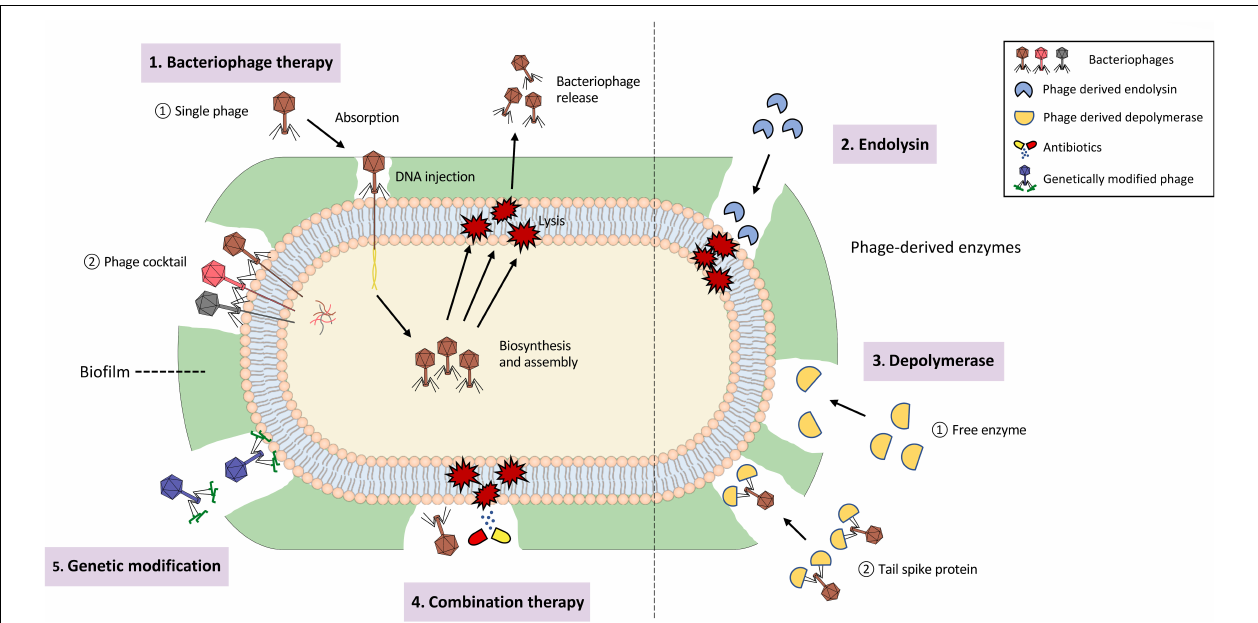
FIGURE 3 | Depiction of biofilm removal using phages and its derived enzymes. (1). Bacteriophage therapy, consisting of single phage therapy and cocktail therapy, that is used for intra- to extracellular degradation of the bacterial structure. (2). Phage-derived endolysin used for extra- to intracellular degradation of the bacterial structure. (3). Phage-derived depolymerase, presented as free enzyme or tail spike protein, that is used for chemical dispersion of the biofilm matrix. (4). Combination therapy using both phages and other antimicrobial compounds, such as antibiotics. (5). Genetically-modified phages that enlarge the host-species interaction